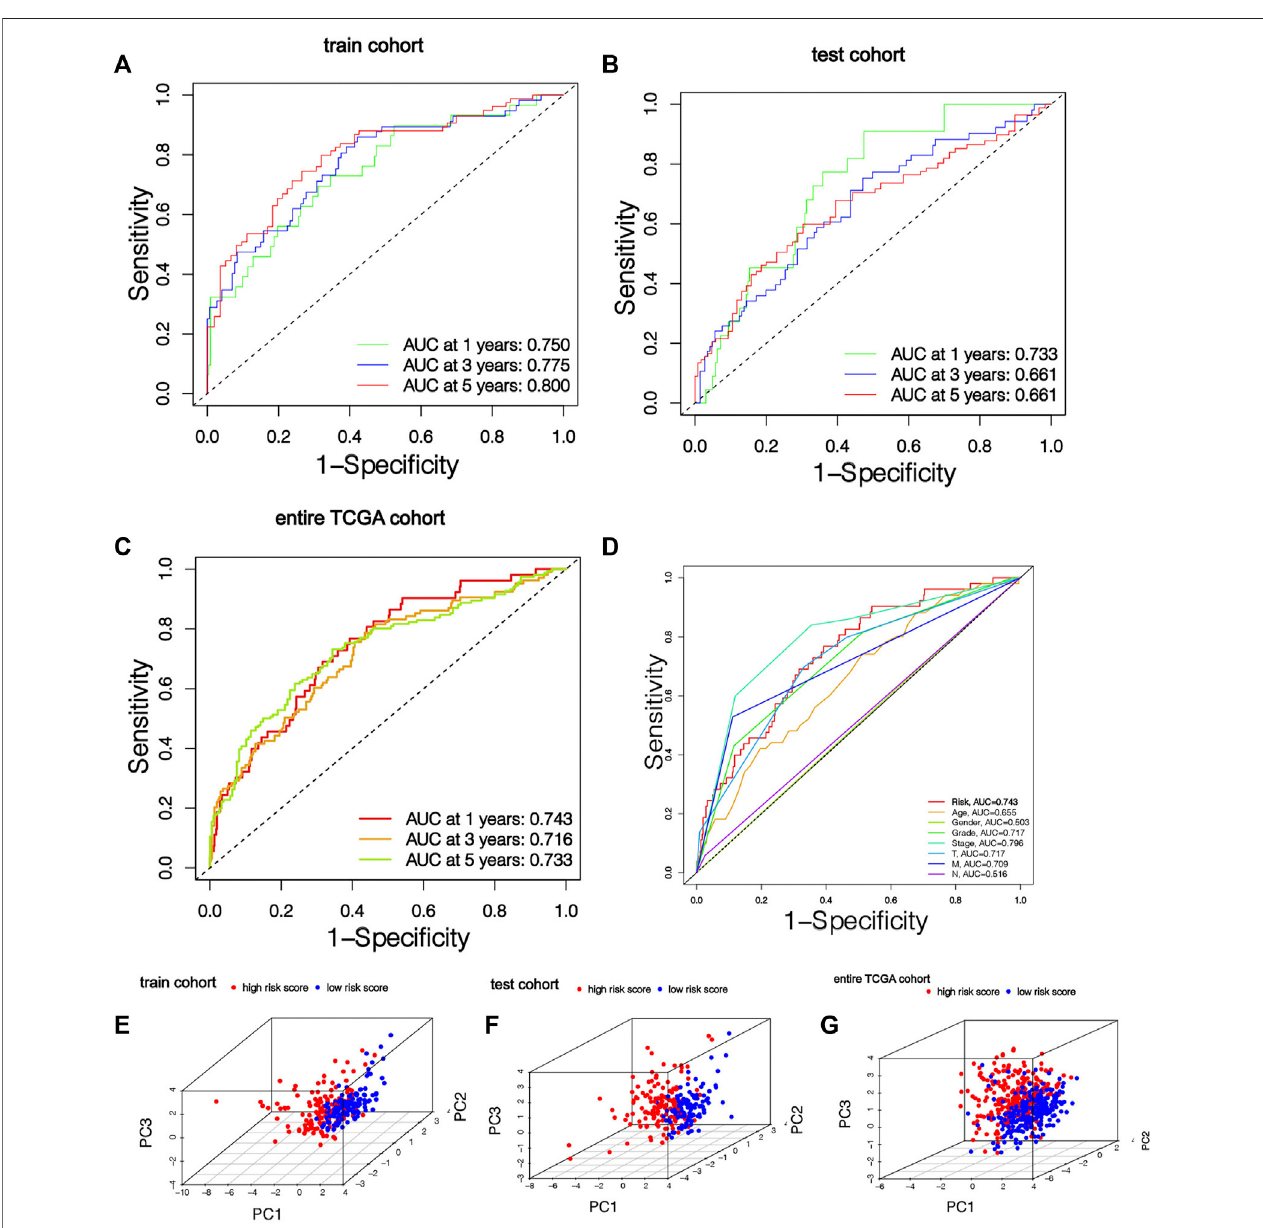
FIGURE4| Therisksignaturehas goodprediction accuracy. (A-C) ROCcurves ofpatients in trainingcohort,testing cohortand entireTCGA cohortbased onrisk score for 1, 3 and 5 years. (D) ROC curve based on risk score and clinical features in the entire TCGA cohort. (E – G) Training cohort, testing cohort and entire TCGA cohort PCA results show that risk score has the ability to divide KIRC patients into two subgroups.